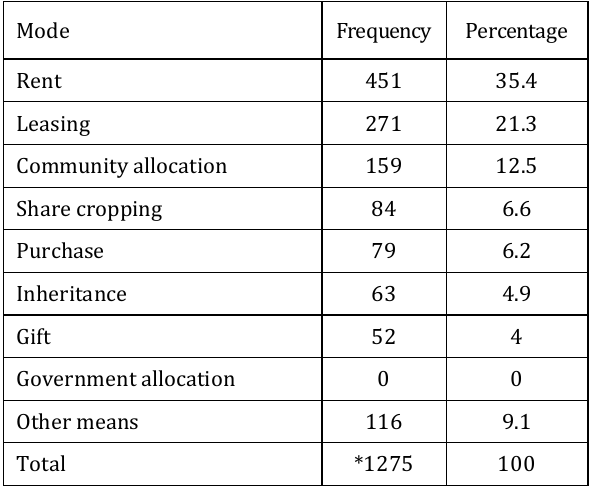
Table 2. Migrants’ mode of accessing land in the study area